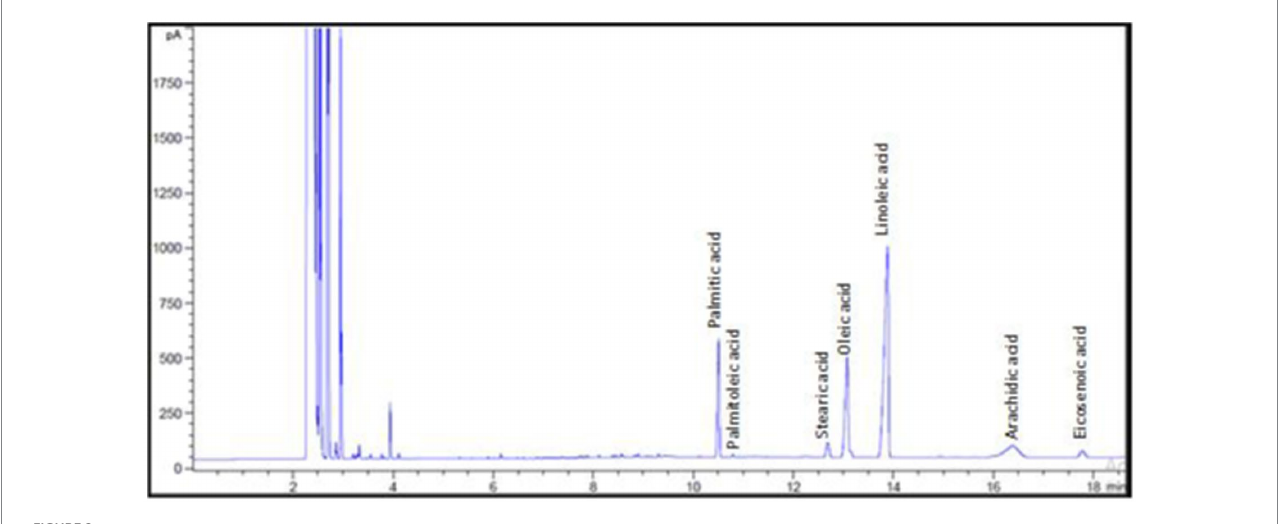
FIGURE 2 Fatty acid composition of Nigella sativa